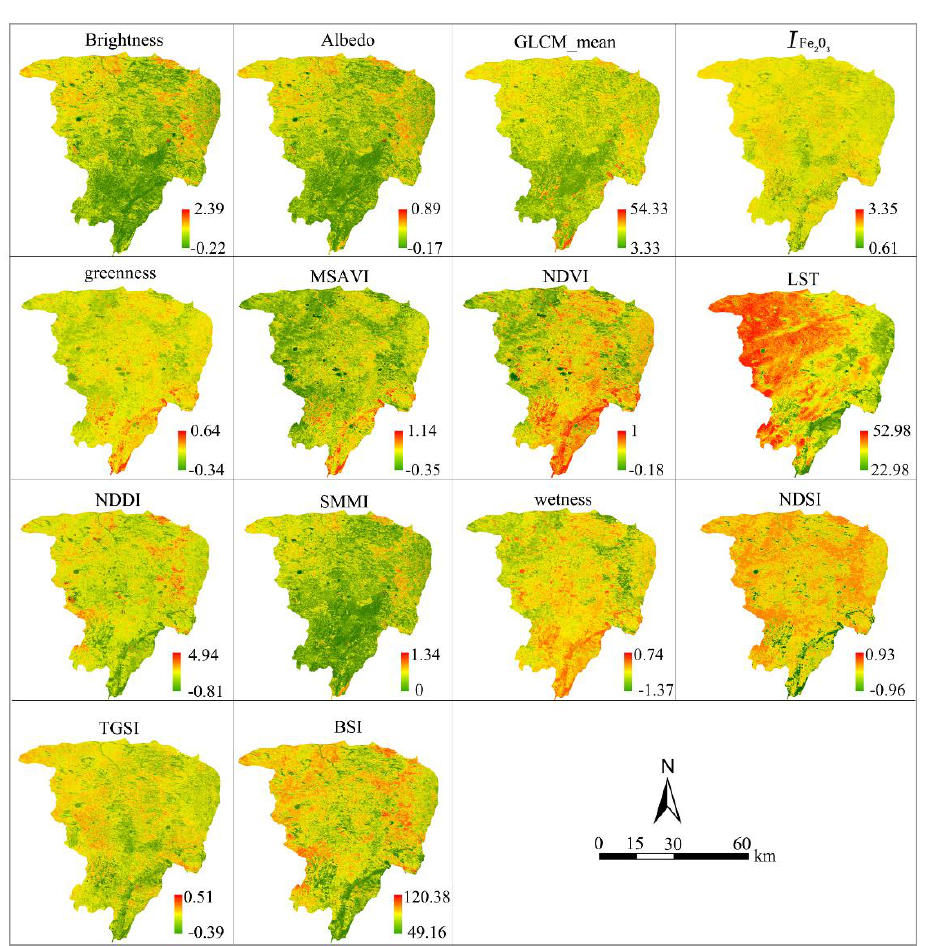
Figure A1. Results of the indicators for aeolian desertification in 2019 in the Zhenglan Banner.